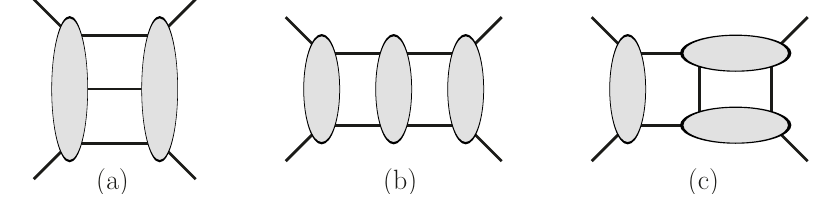
Figure 11 . A spanning cuts that determine the full integrand other than quantum bubble on external leg contributions. The complete set of cuts is given including all distinct labels and routing of di(cid:11)erent particles through the cuts. The lines represent on-shell particles of any type.